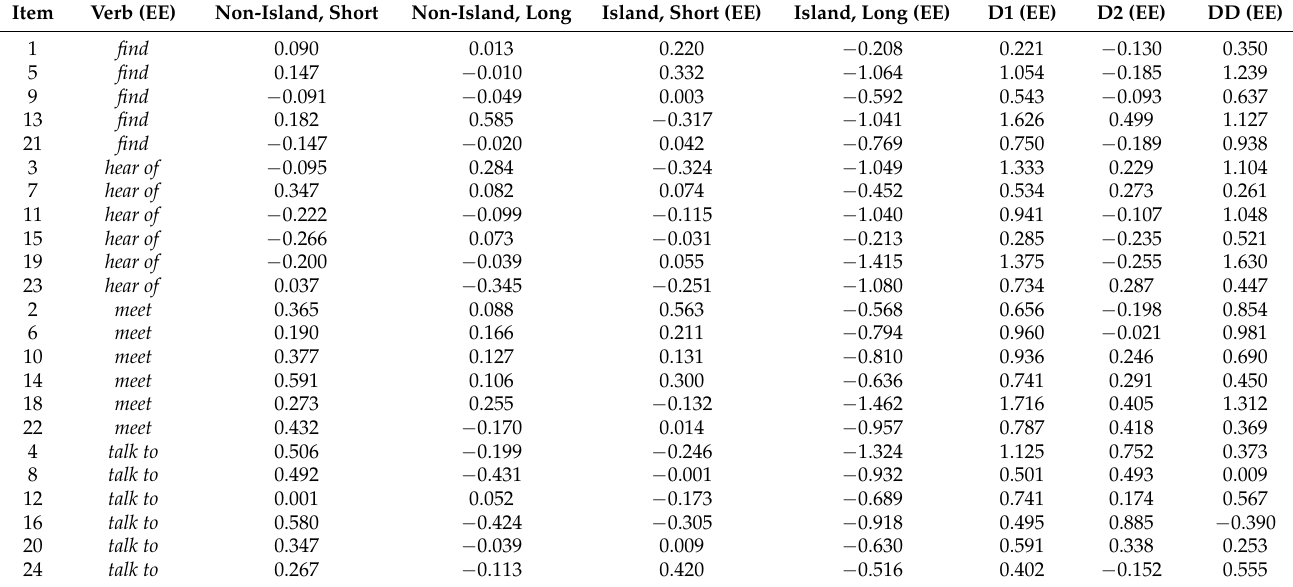
Table A10. DD score calculation table for Experiment 3. The table displays the z-scored ratings for Section 2 for a description of the procedure for calculating DD scores. The DD scores below are averaged for each verb and presented in Figures 9 and